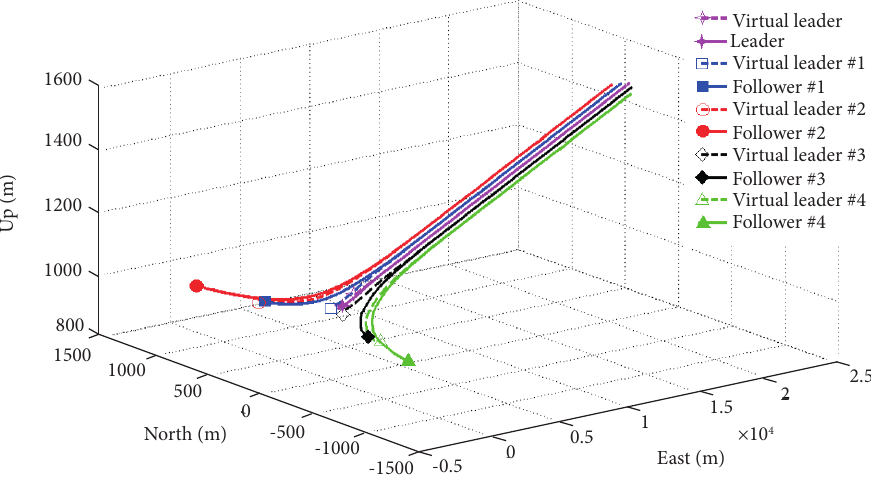
Figure 10. Straight maneuver in East direction with altitude increase.